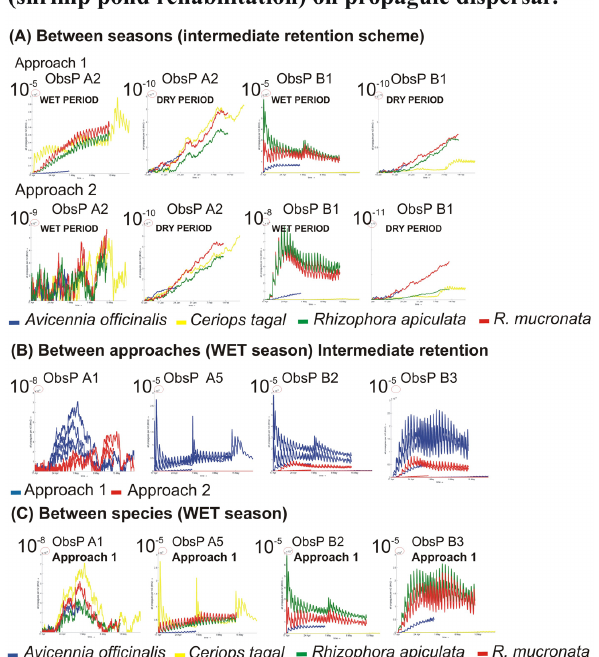
Fig. 8. Results of scenario 4 (the effect of dike removal) showing the time-series plots of Avicennia officinalis, Ceriops tagal and Rhi- zophora apiculata and Rhizophora mucronata . A comparison was made between (A) seasons (wet versus dry season), (B) approaches of outer dike removal (In approach 1, 60m of an outer dike was removed at the northeastern side of shrimp farm A and the north- ern side of shrimp farm B, while in approach 2 part 60m of the outer dike at the southeastern side of shrimp farm A and the north- western side of shrimp farm B was removed) and (C) the different species. ObsP Ax = observation point in shrimp farm area A, ObsP Bx = observation point in shrimp farm area B. X-axes = buoyancy period (days), y-axes = propagule density m − 2